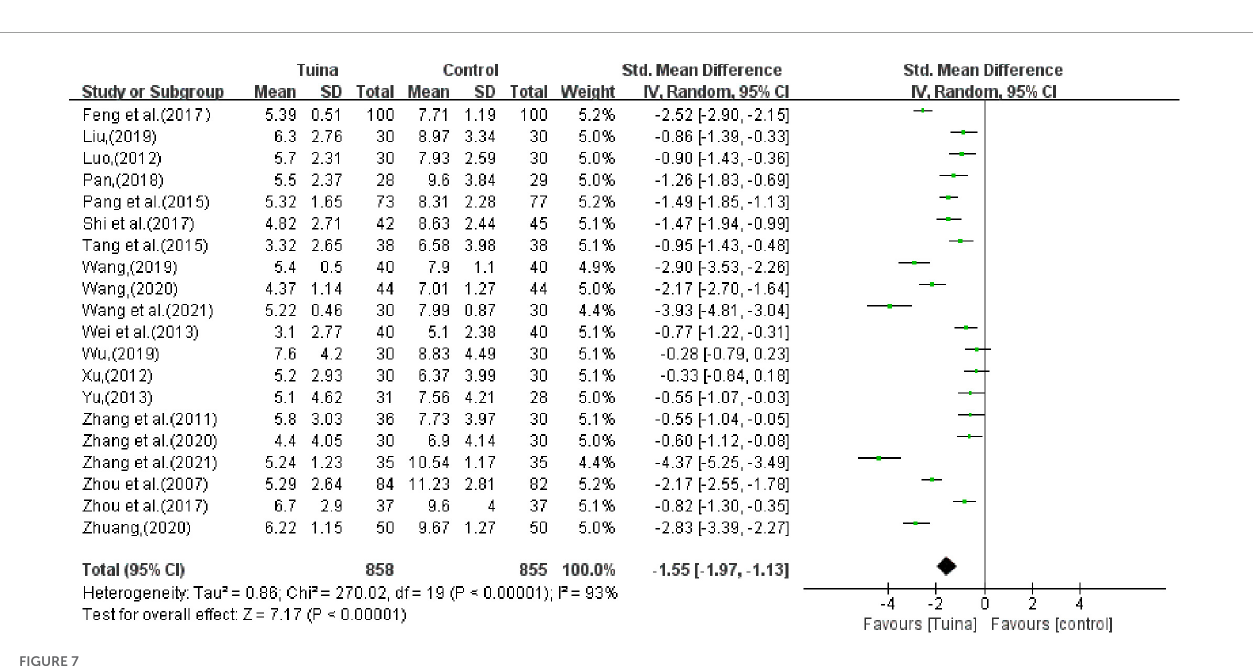
FIGURE7 Meta-analysis of Pittsburgh Sleep Quality Index